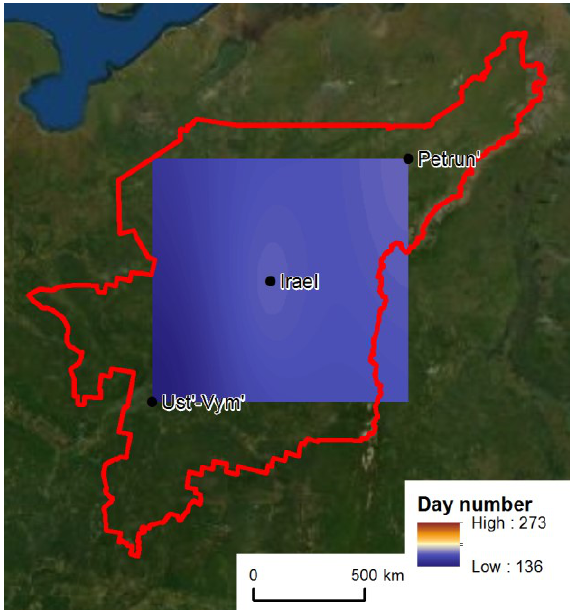
Figure 5. Beginning days of spring growing season interpolated between meteorological stations